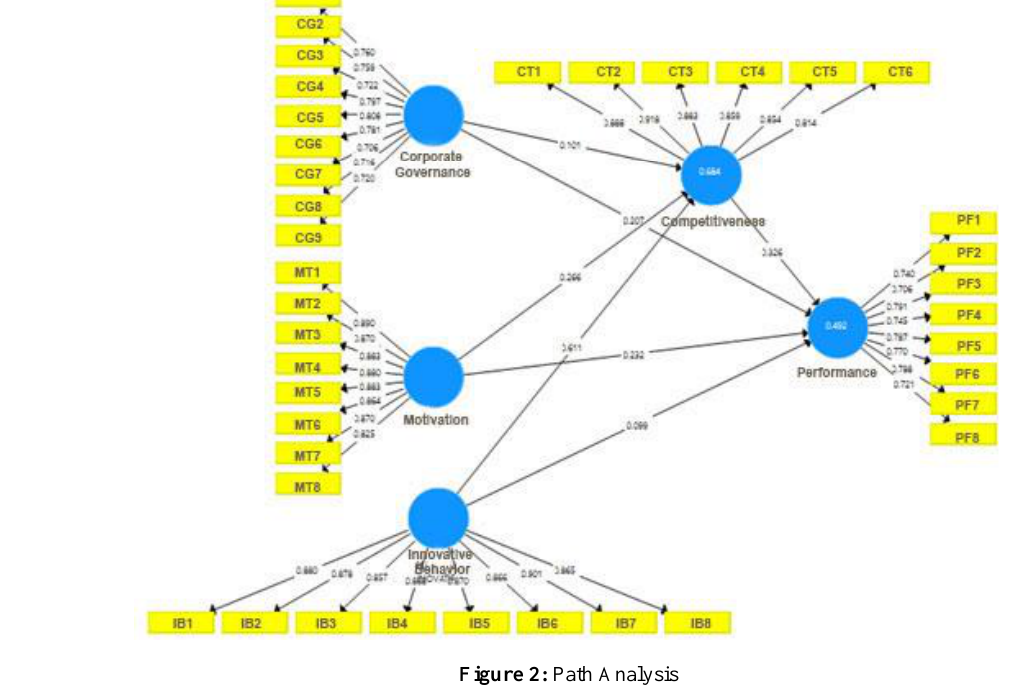
Figure 2: Path Analysis Table 2: Direct Effects Between Variables